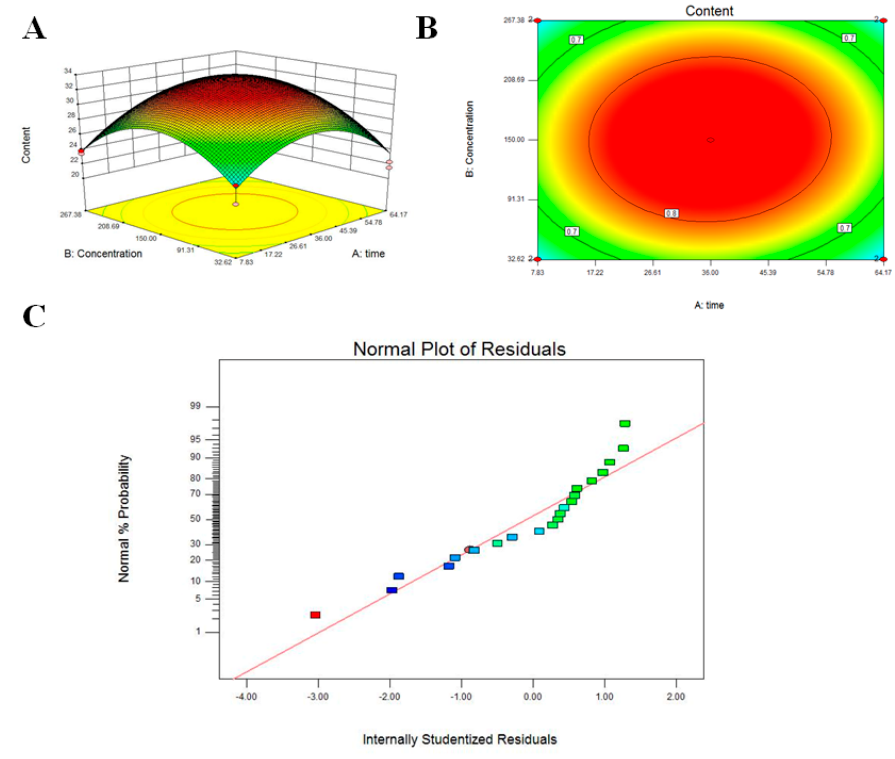
Figure 3. Results of response surface methodology for the optimization of lysine content induced by citric acid in Flammulina filiformis . ( A ) 3D response surface view. A 5-level 2-factor design requiring 21 experimental combinations was employed in this optimization study. Table S2 shows the range and level of the independent variables. Each experiment was repeated three times and the mean lysine value was calculated. The experimental data were analyzed by a second-order polynomial regression. ( B ) Contour plots reflect the combined effects of concentration and treatment time on lysine content in F. filiformis . ( C ) Residual normal probability distribution map. Each color block is a response